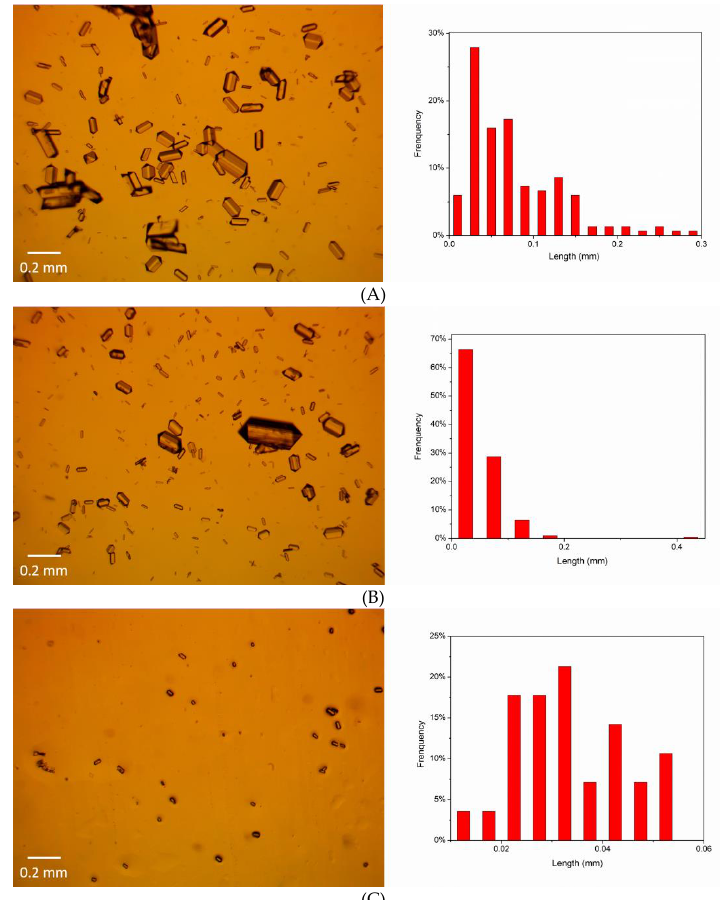
Figure 7. ( A ) (Left) Off-line microscope images (with polarizer) of crystals in a 1-mL batch after 10 min (residence time). The batch experimental details are in Table 1, Batch 1 , under the same experimental conditions as in slug flow experiments (Table 1, Condition 1). (Right) CSD of the microscope image on the left. ( B ) (Left) O ff -line microscope images (with polarizer) of crystals in a 5 mL batch after 10 min (residence time). The batch experimental details are in Table 1, Batch 2, under the same experimental conditions as in the slug flow experiments (Table 1, Condition 1). (Right) CSD of the microscope image on the left. ( C ) (Left) O ff -line microscope images (with polarizer) of crystals in a 50 mL batch after 10 min (residence time). The batch experimental details are in Table 1, Batch 3, under the same experimental conditions as in slug flow experiments (Table 1, Condition 1). (Right) CSD of the microscope image on the left. The crystal data for after one day are shown in Figure